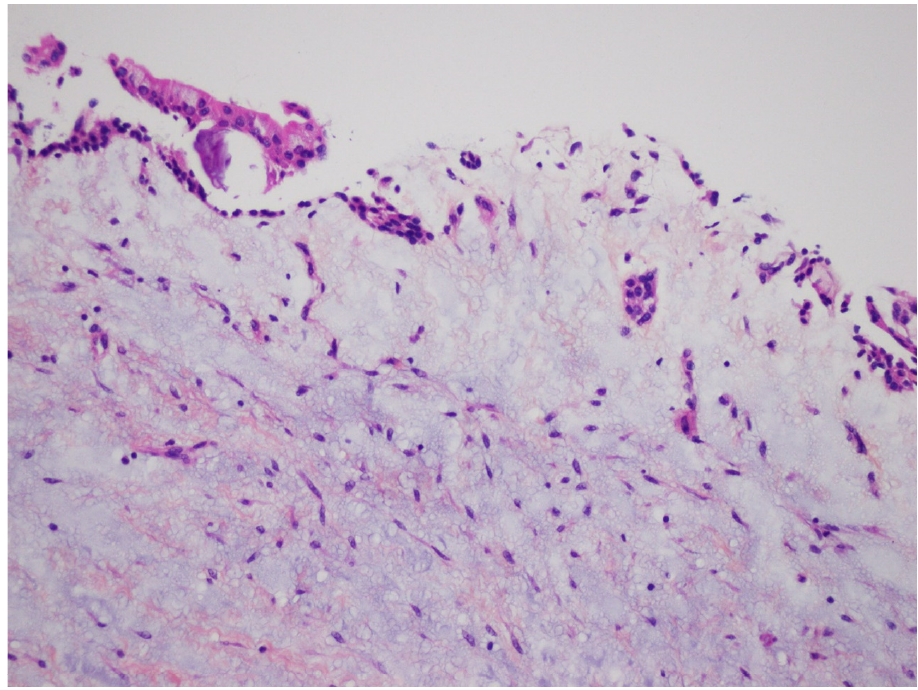
Figure 14. Dental follicle partly lined by reduced enamel epithelium (H&E, ×